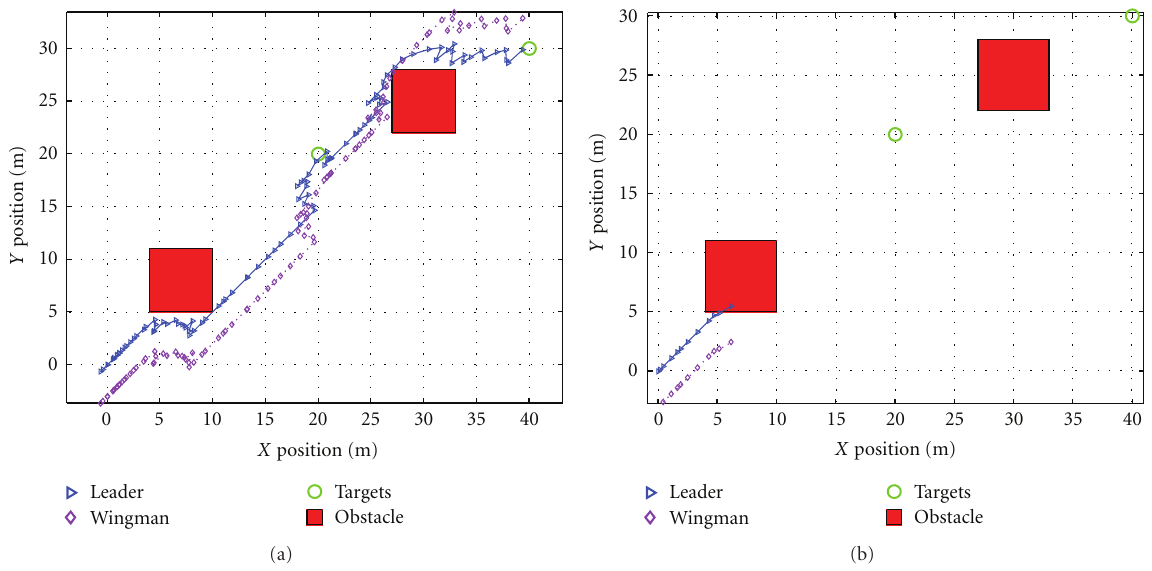
Figure 9: Decentralized formation flight with robustness and without robustness. (a) Formation flight with robustness. (b) Formation flight without robustness.